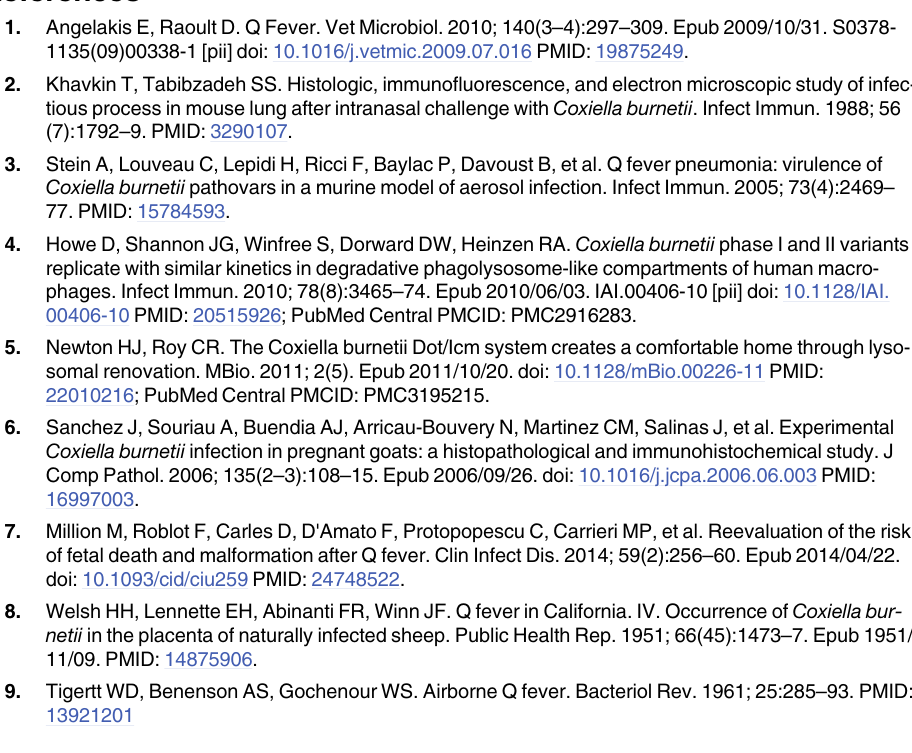
S3 Table. Molecular weights of hypothetical proteins encoded by genes upregulated > 5-fold in 21 day SCV. S4 Table. Mass spectrometry of C . burnetii